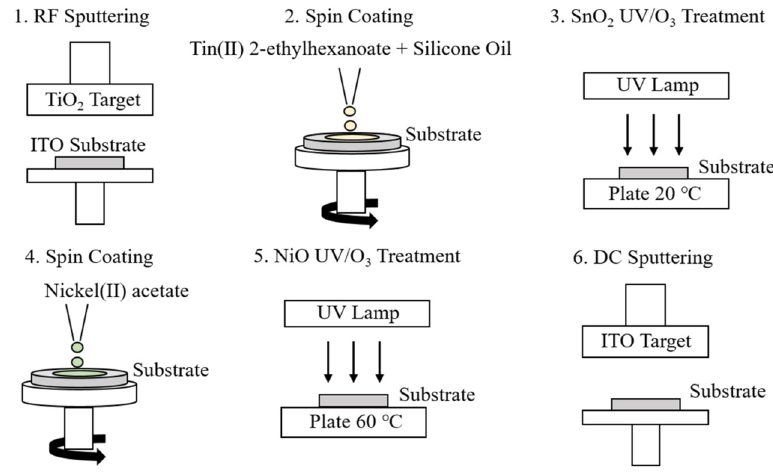
Figure 2. Fabrication process flow of all-solid-state EC device using a spin coater.